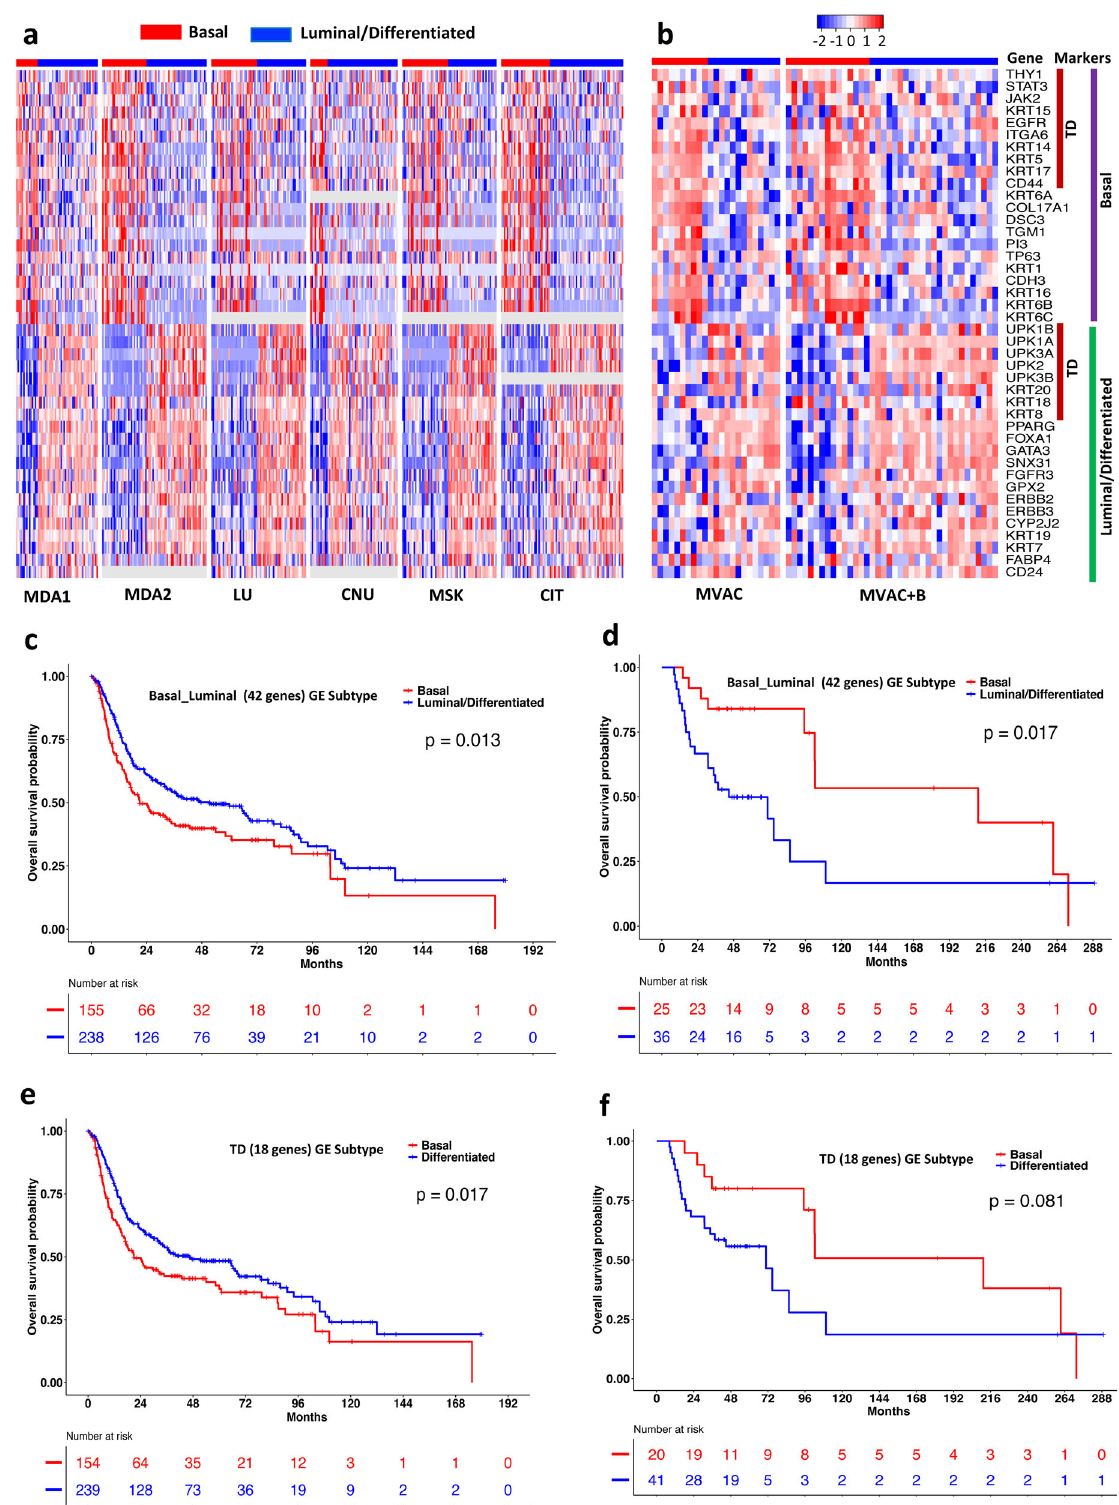
Fig. 5 Prognostic power of tumor differentiation (TD) and basal-luminal gene expression signatures. a , b Heatmaps of gene expression of 42 basal- luminal genes (including 18 TD genes) in the 6 retrospective study cohorts (MDA1, MDA2, LU, CNU, MSK, CIT) ( a ) and the 2 clinical trial cohorts (MVAC, MVAC + B) ( b ). c , d Patient overall survival strati fi ed by the basal and Luminal subtypes de fi ned by the 42 basal-luminal genes in the 6 retrospective study cohorts ( c ) and the 2 clinical trial cohorts ( d ). e , f Patient overall survival strati fi ed by the basal and differentiated subtypes de fi ned by the 18 TD genes in the 6 retrospective study cohorts ( e ) and the 2 clinical trial cohorts ( f ). MDA1: MD Anderson Cancer Center (USA) cohort 1; MDA2: MDA cohort 2;